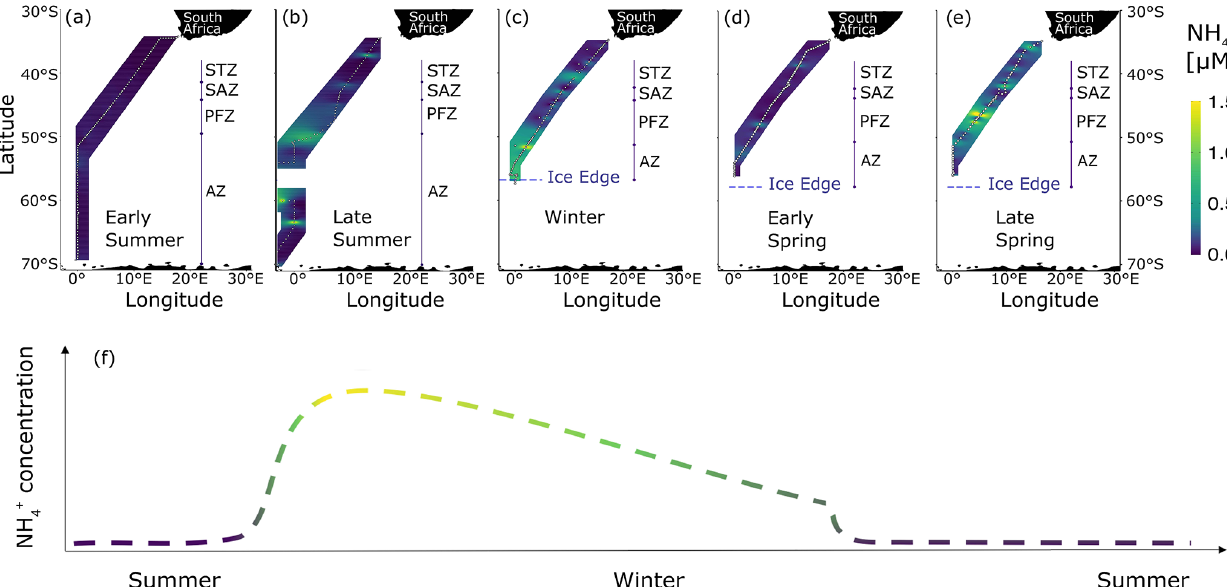
Figure 8. Surface concentrations of NH + across the eastern Atlantic sector of the Southern Ocean measured between December 2018 and 4 November 2019. Five unique transects (additional to the winter 2017 dataset presented in Fig. 2a) are shown: (a) early summer 2018, (b) late summer 2019, (c) winter 2019, (d) early spring 2019, and (e) late spring 2019. (f) The proposed seasonal cycle of NH + concentrations in 4 the mixed layer south of the Subantarctic Front. The colour gradient in (f) shows the transition between late summer and late winter. Panels (a, b) cover a latitudinal extent of 30–70 ◦ S, while panels (c–e) cover 30–60 ◦ S due to the presence of sea ice. Abbreviations are as in Fig. 1, with AZ referring to the combined OAZ and PAZ. Figure produced using the package ggplot2 (Wickham, 2016).